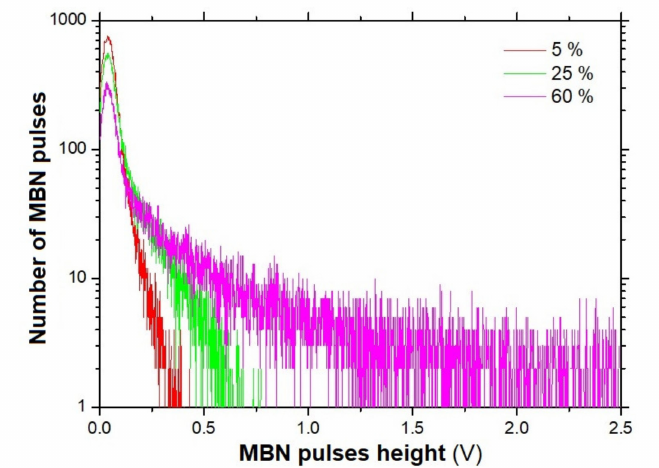
Figure 13. MBN pulses height distribution for different ε , 0 ◦